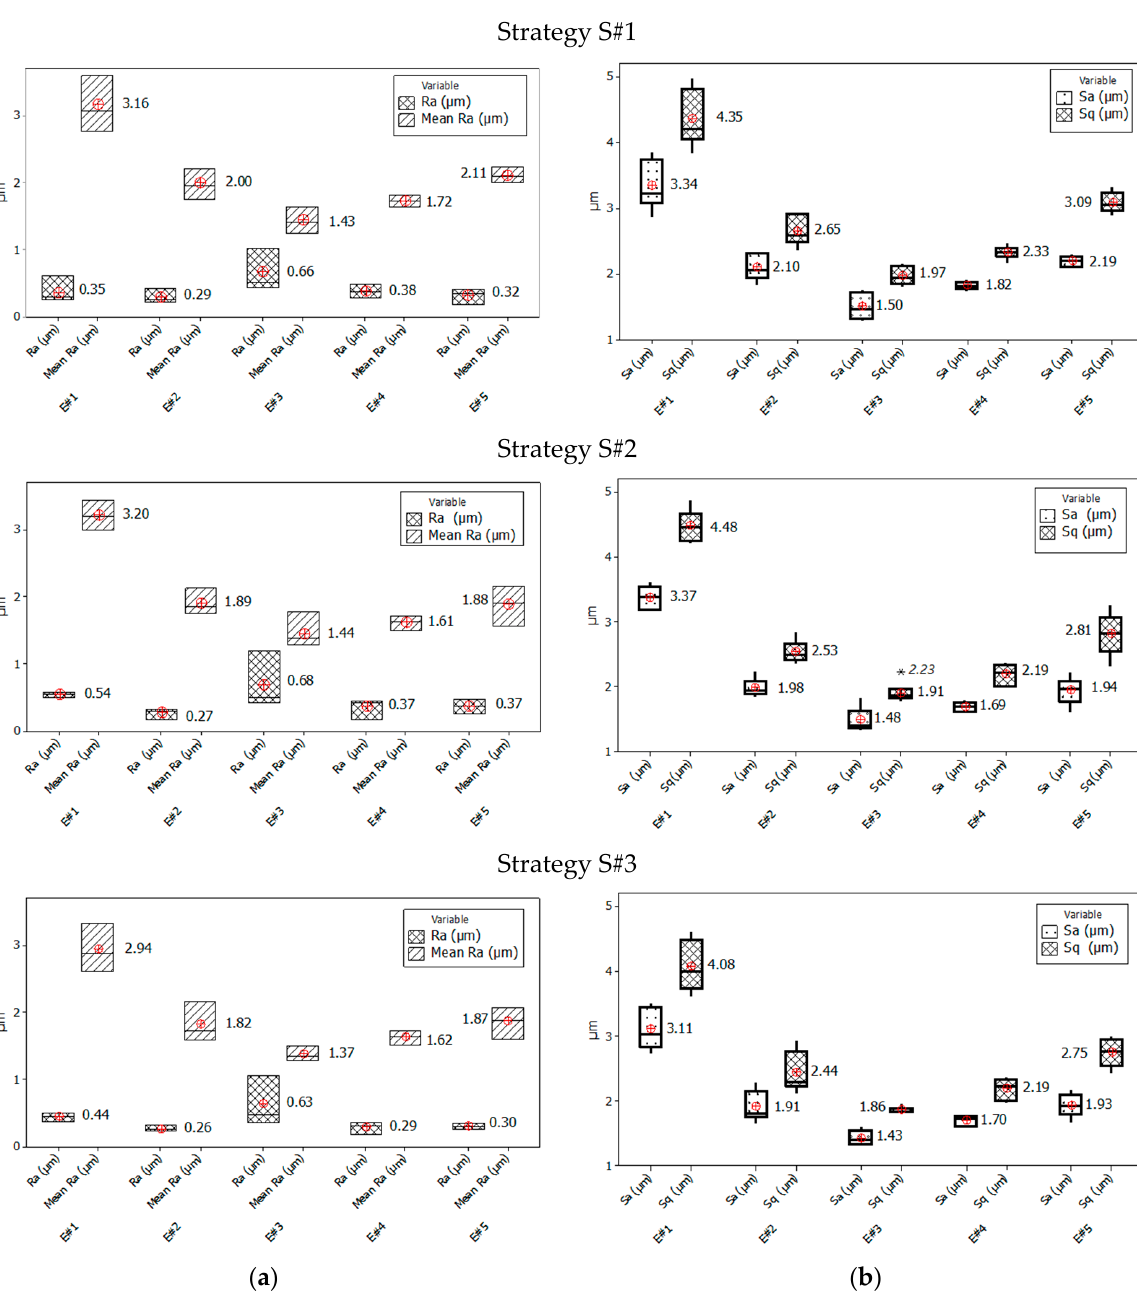
Figure 6. Centre and spread of 2D ( a ) and 3D ( b ) surface roughness parameters for three milling strategies: S#1, S#2 and S#3. 2D parameters ( a ): Ra for the mean R profile and mean Ra parameter. 3D parameters ( b ): Sq and Sa parameters. The box plot presents the mean, the median, the interquartile range box and the range of the data. E#1, E#2, E#3, E#4 and E#5 are names of measurement areas. * Outlier value Sq = 2.23 µ m, in 3D ( b